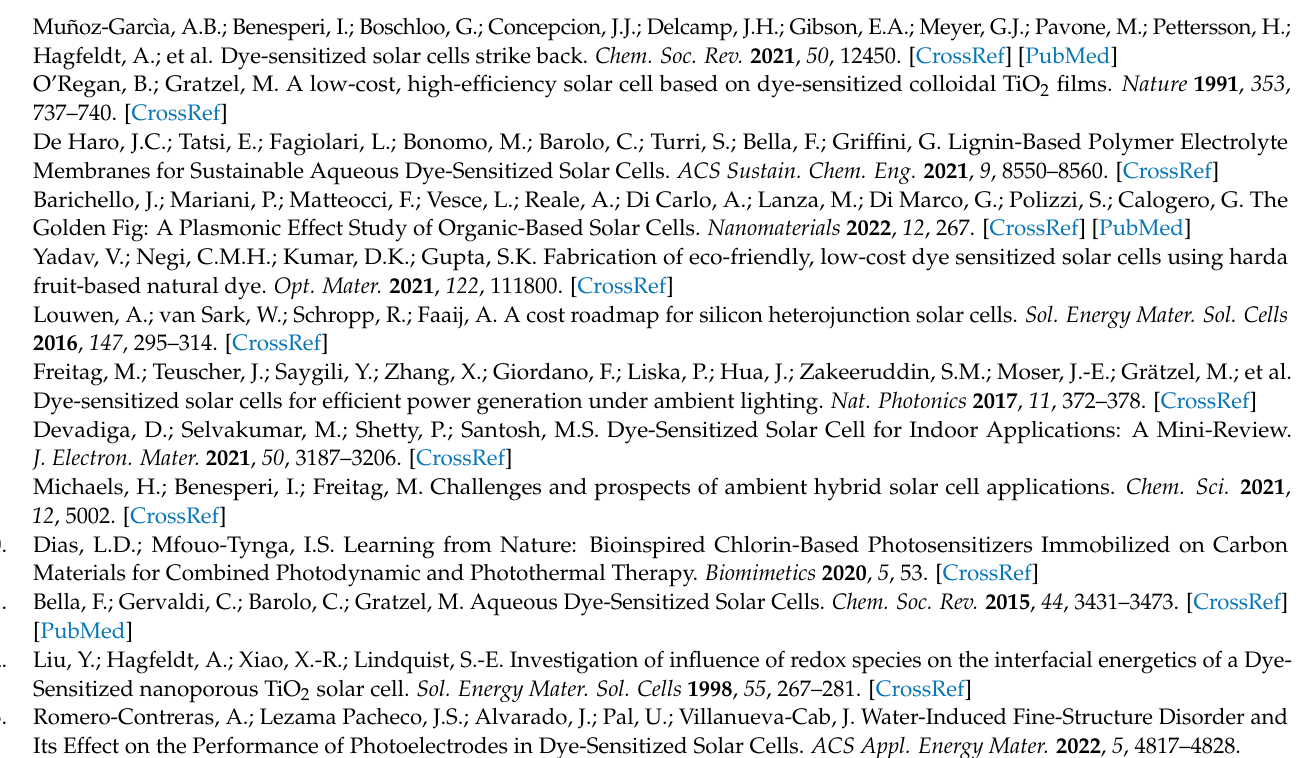
acid BODIPY 2.; Figure S11: Differential pulse voltammograms of BODIPY 1 in acetonitrile (scan rate 20mV/s) (Fc= Ferrocene); Figure S12: Differential pulse voltammograms of 1BODIPY 2 in acetonitrile (scan rate 20mV/s) (Fc= Ferrocene).; Figure S13: I-V curve of BODIPY 1, Figure S14: I-V curve of BODIPY 2, Figure S15: Incident photon-to-current conversion efficiency (IPCE) and Integrated current density for the best realized device of (A) BODIPY 1 and (B) BODIPY 2. Table S1: Photovoltaic performances of realized devices for BODIPY 1 and BPDIPY 2. In acetonitrile and I-/I3- as mediator. Table S2: Photovoltaic performances of realized devices for BODIPY 1 and BPDIPY 2. In water and Q/H2Q as